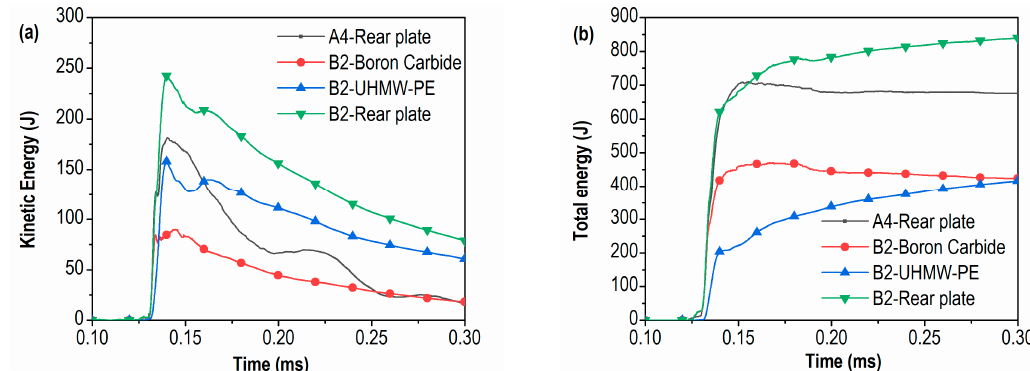
Figure 14. The energy histories of the rear plate: ( a ) kinetic energy and ( b ) total energy.